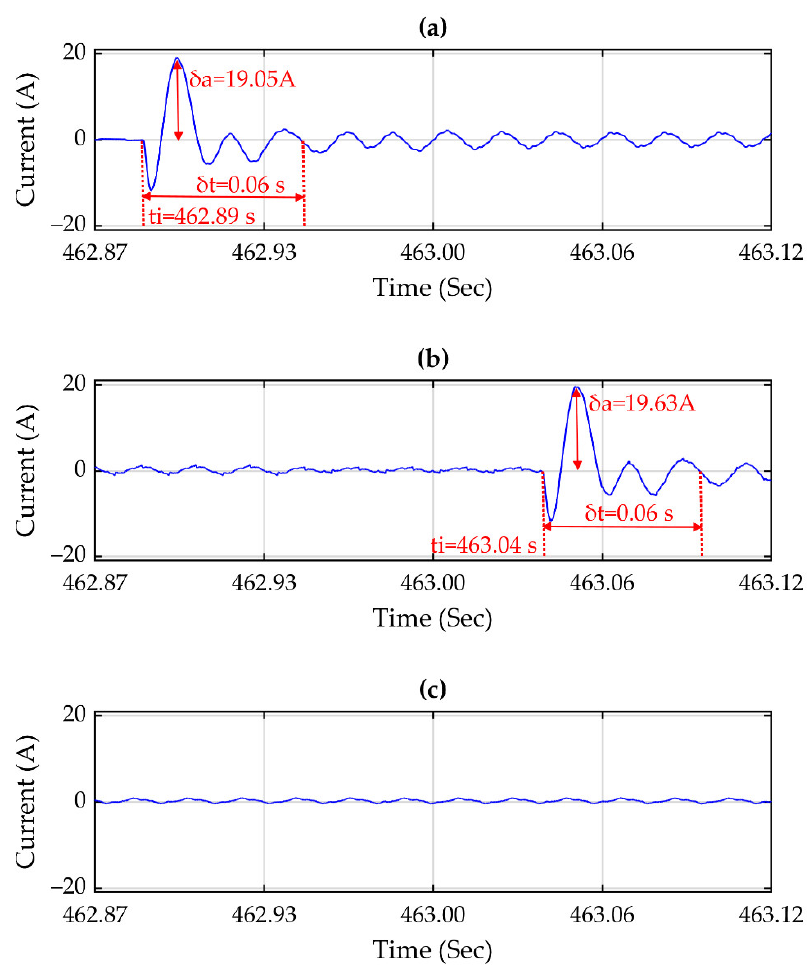
Figure 12. Signals ( a – c ) correspond to GPS synchronized data logger GSD-1, GSD-2, and GSD-3, and the graphics show an impulsive transient propagated to two locations on the grid.